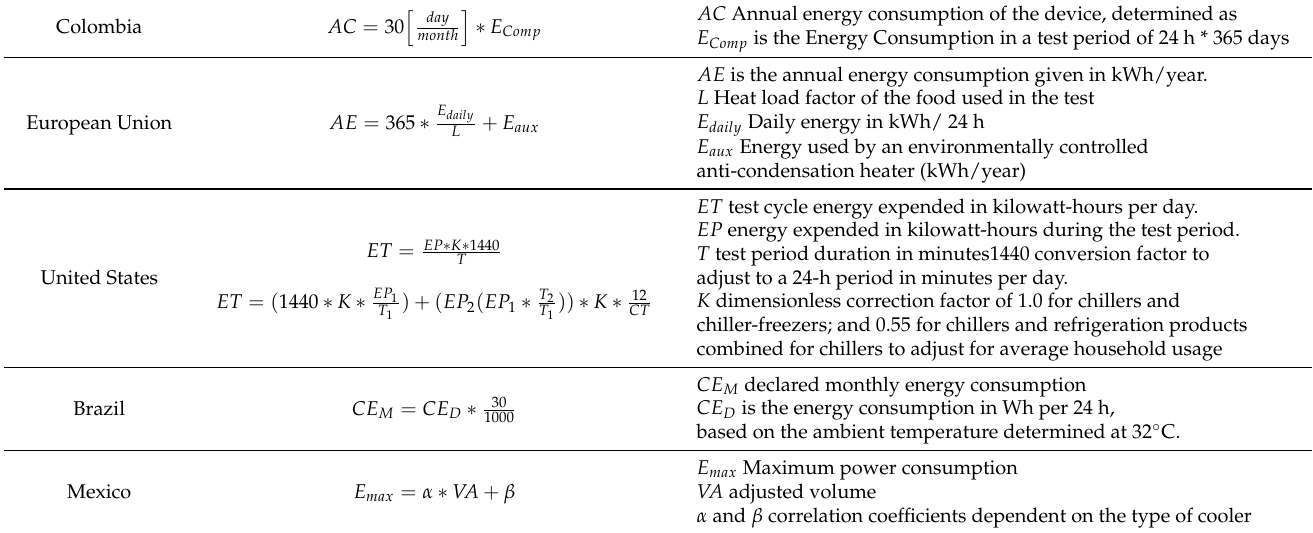
Table 5. Formulation for calculating energy consumption Colombia and reference